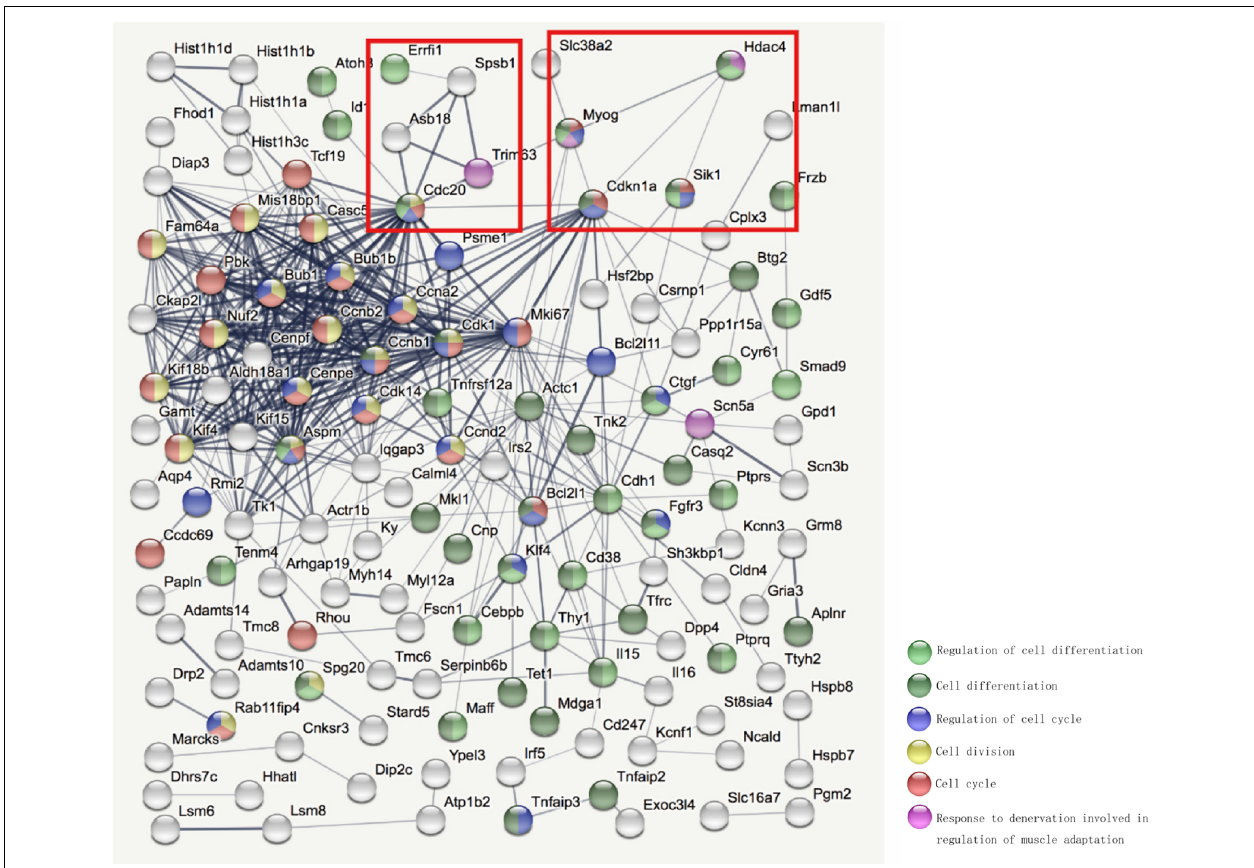
FIGURE 4 | STRING (https://string-db.org/) was used to further analyze the interaction network among the selected differentially expressed genes. Bottom right corner of the image: Different colored balls represent different biological